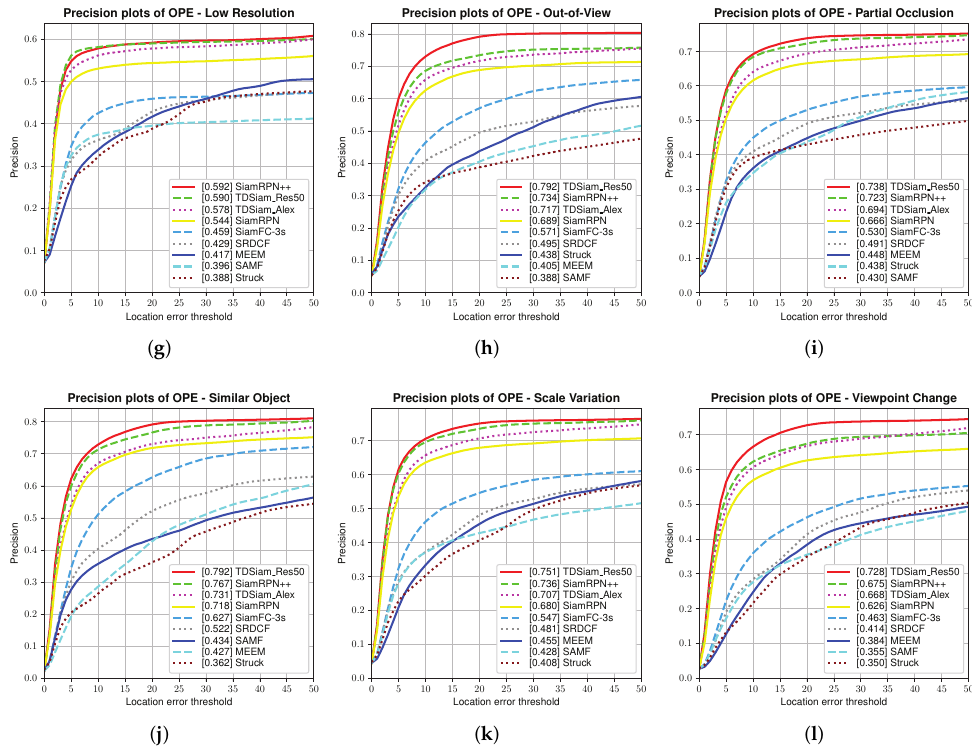
Figure 10. Precision plots corresponding to some different scenarios. The UAV20L dataset was used for the evaluation. ( a ) Aspect Ratio Change; ( b ) Background Clutter; ( c ) Camera Motion; ( d ) Fast Motion; ( e ) Full Occlusion; ( f ) Illumination Variation; ( g ) Low Resolution; ( h ) Out of View; ( i ) Partial Occlusion; ( j ) Similar Object; ( k ) Scale Variation; ( l ) Viewpoint Change.